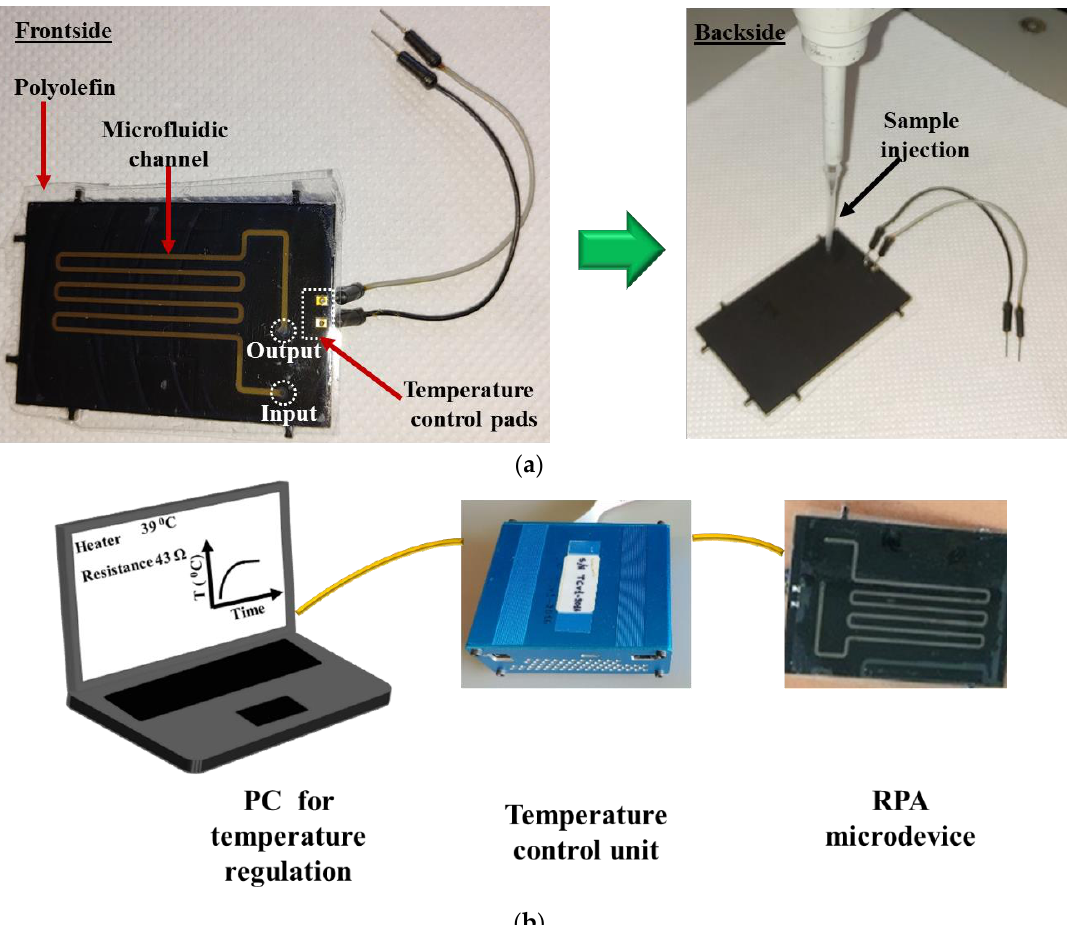
Figure 4. ( a ) Image of the frontside and backside of the RPA-on-PCB chip ready for use. The microfluidic channel and the sealing film (polyolefin) are depicted (left). Image of the backside of the device during the introduction of a RPA solution in the microchannel (right). ( b ) Schematic representation of the experimental set-up, comprising the RPA-on-PCB chip, the temperature control unit, and the PC with the user interface.